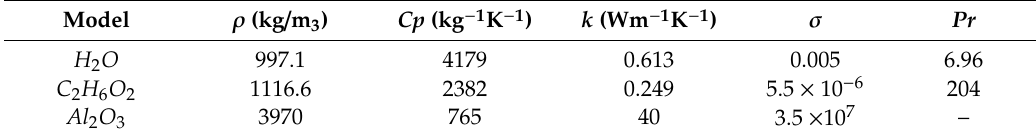
Table 1. Thermophysical properties of the flow models for gamma-alumina nanoparticles.